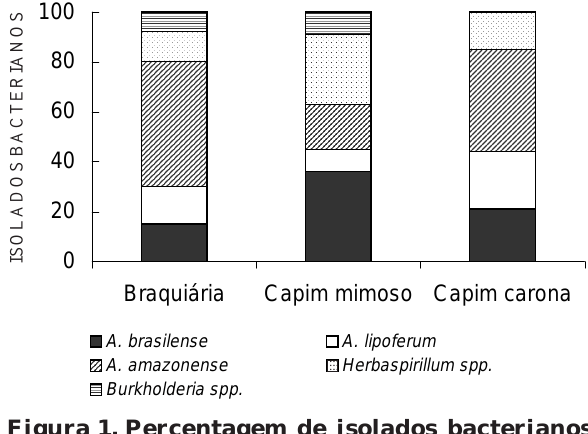
Figura 1. Percentagem de isolados bacterianos caracterizados morfologicamente como A. brasilense, A. lipoferum, A. amazonense, Herbaspirillum spp., Burkholderia spp. obtidos de braquiária, capim mimoso e capim